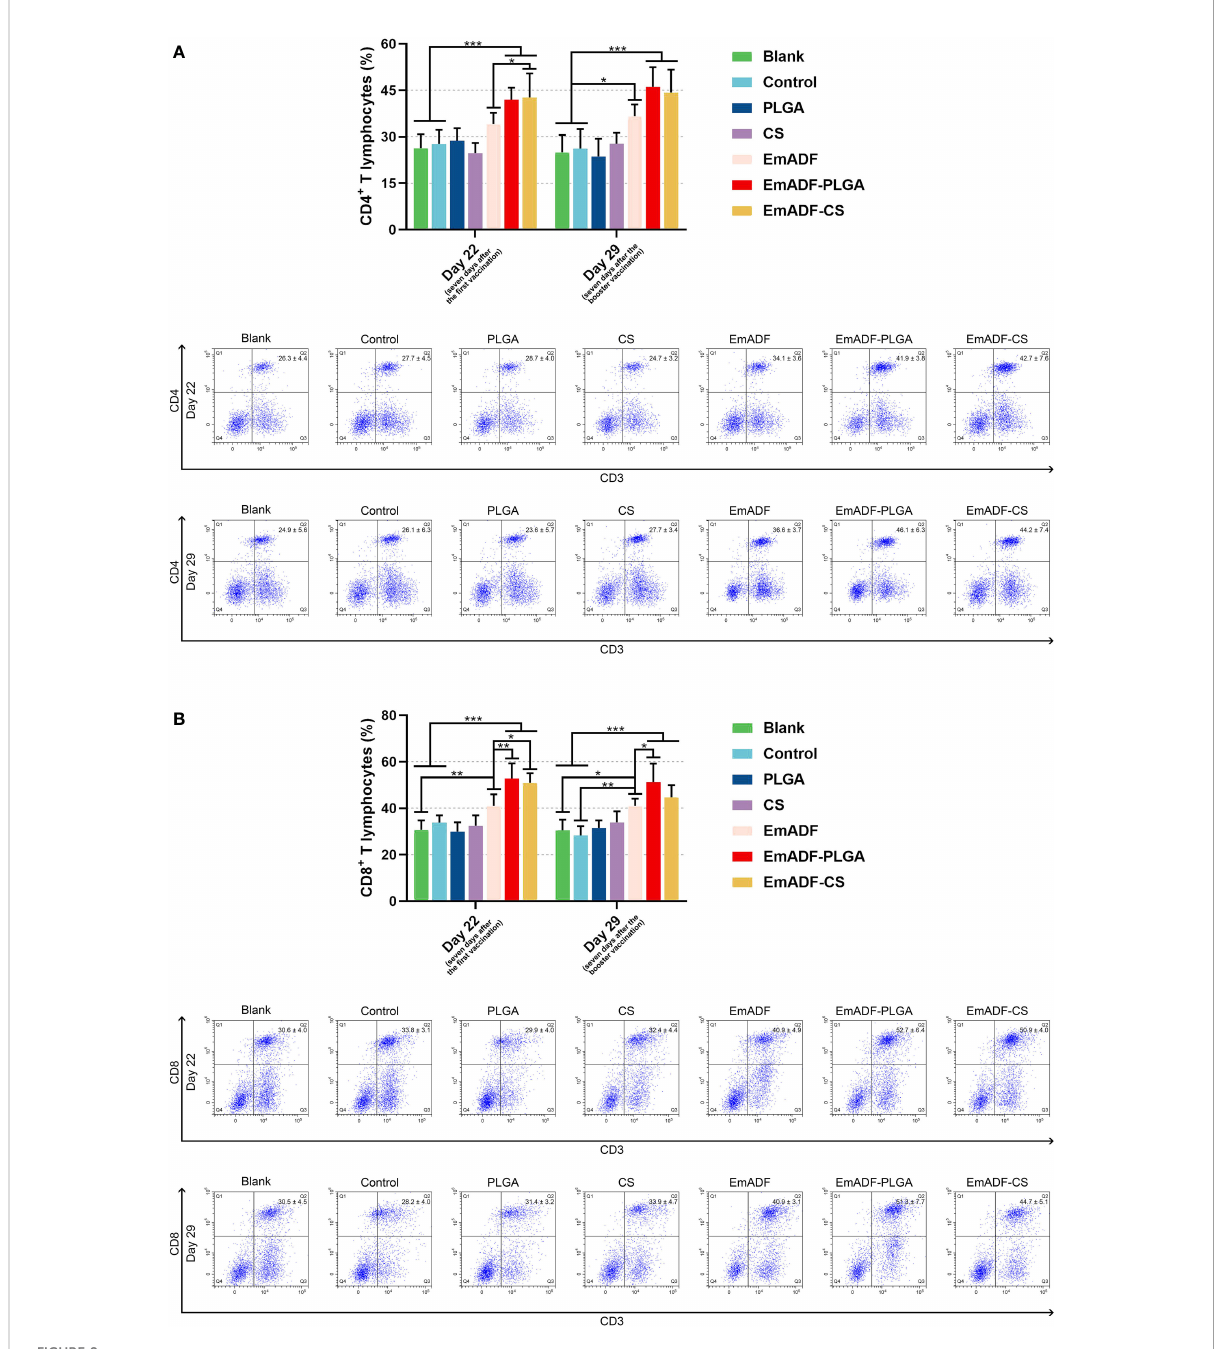
FIGURE 8 Flow cytometry analysis of CD4 + (A) and CD8 + T lymphocytes (B) in splenocytes at the age of 22 and 29 day. Chickens in each group were sacri fi ced, and the lymphocytes was collected. Adequate compensation was conducted before cell sorting, and the lymphocytes were analyzed by fl ow cytometry. Each group involved fi ve biological replicates, and each replication was detected once. Values were estimated using one- way ANOVA analysis followed by Dunnett ’ s test. Comparisons among EmADF, EmADF-PLGA, and EmADF-CS group were conducted by ANOVA following Bonferroni ’ s correction. Values were presented as the mean of the mean ± SD. * p< 0.05, ** p< 0.01, and *** p<